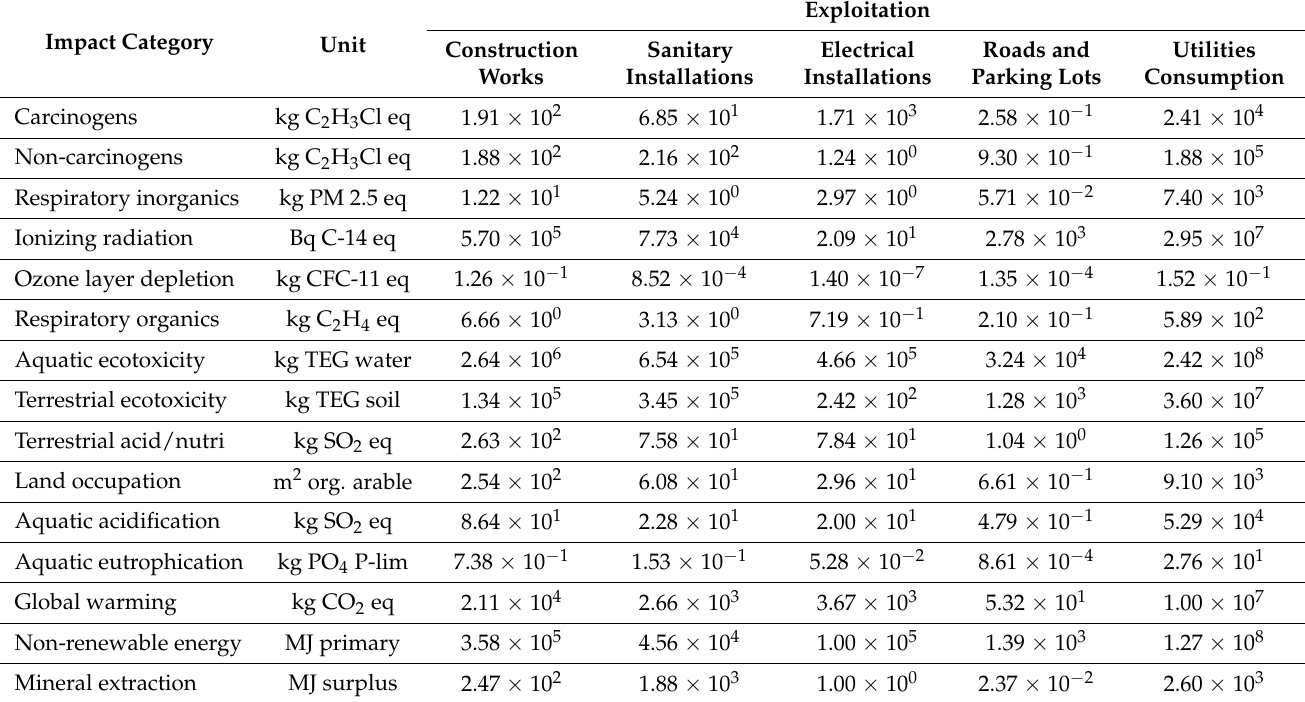
Table 5. The results of characterizing the environmental consequences occurring at the stage of operation of the research object by the groups of